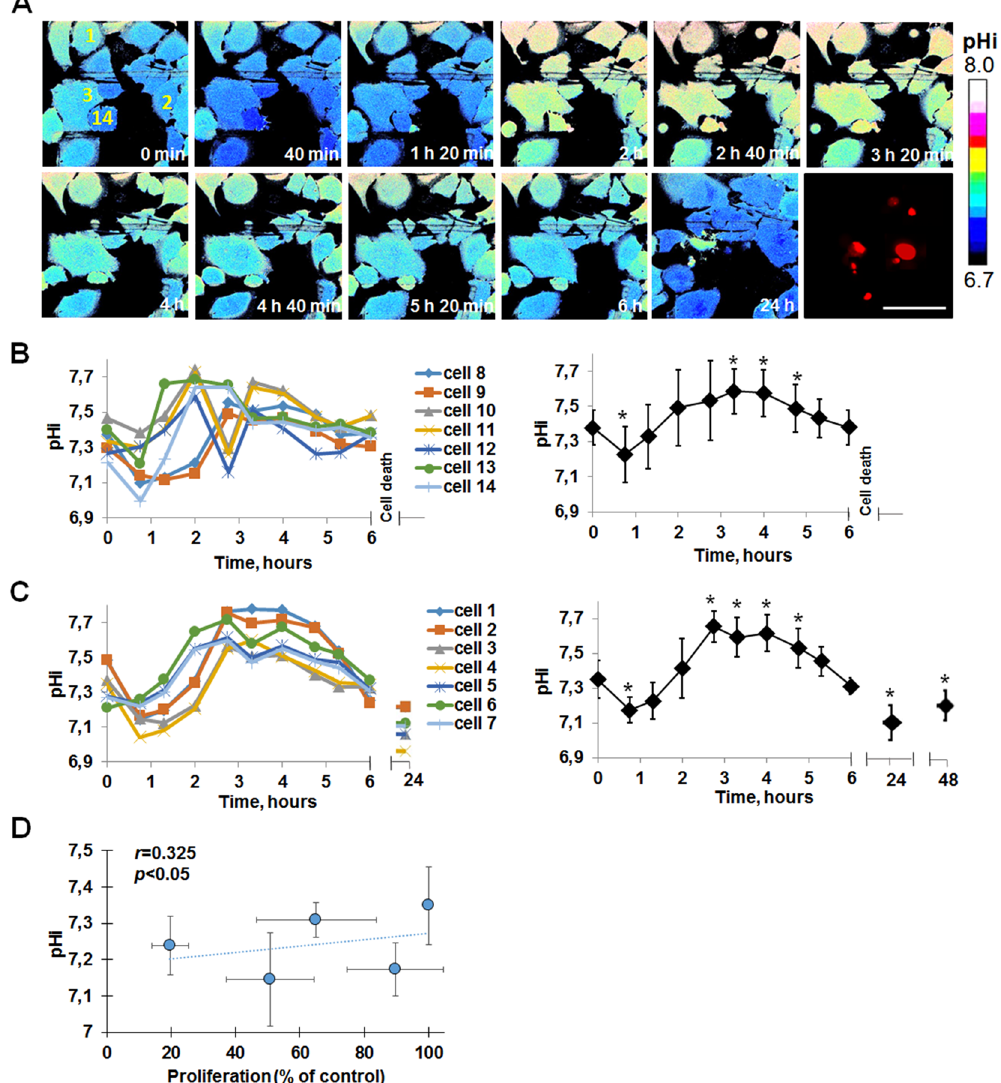
Figure 2. pHi in HeLa-SypHer2 cancer cells under cisplatin exposure. ( A ) Representative time-course pHi imaging during cisplatin exposure and propidium iodide staining at 24 hours. Time after adding cisplatin is indicated on each image. Early changes of pHi in the individual cells and quantification of pHi in cells that further die ( B ) or reduce proliferative activity ( C ). Mean ± SD. In ( B ) n = 75 cells, in ( C ) n = 11 cells. ( D ) Pearson’s correlation between pHi and cell proliferation. Proliferation is expressed as % of untreated control cells counted on the same day. Cell death occurred between 6 and 24 hours of exposure to cisplatin. Monitoring pHi during and at the moment of cell death was out of the scope of this study. The cells indicated by the numbers in ( A ) correspond to the individual cells shown in ( B , C ). Bar is 50 µ m (applicable to all images). * Statistically significant difference from the initial pHi value, p ≤